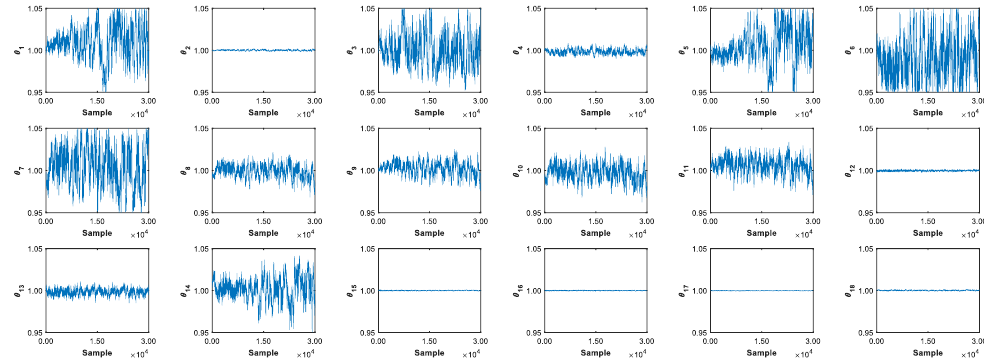
Figure A11. Parameters random